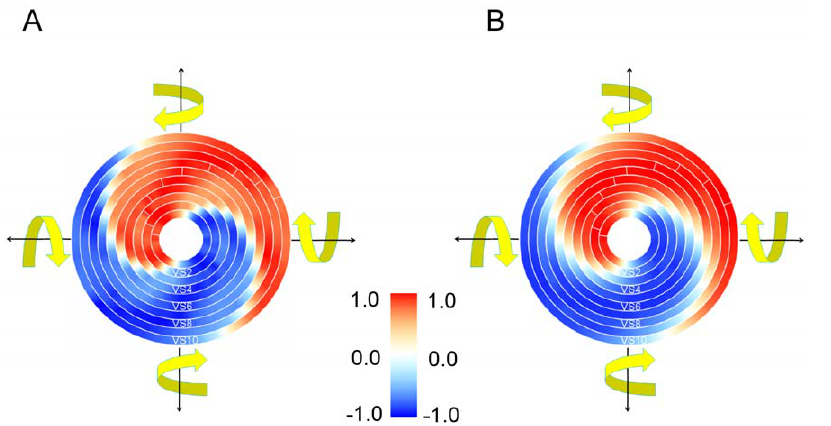
Figure 7. Action fields for rotation within the horizontal plane of all VS-cells, shown in false color code. Responses were normalized for each cell to their maximum. a Action fields with all connections of the network intact. b Action fields with all connections of the network removed. The action field of VS1 corresponds to the inner most ring, while VS10’s tuning is depicted in the outer most ring.